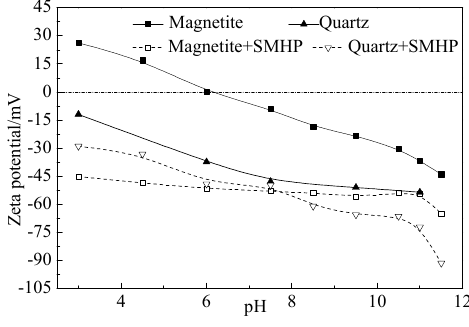
Figure 8. The zeta potential of magnetite and quartz particles.